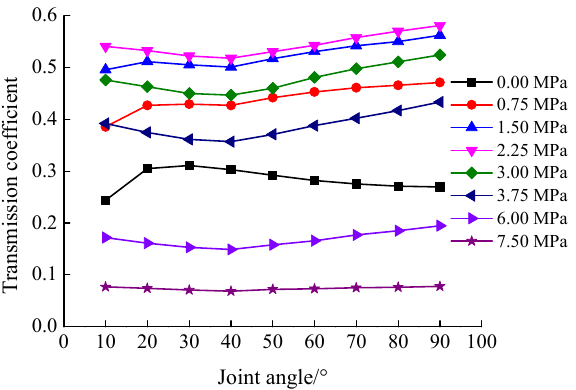
Figure 12. Effect of the joint angle on the transmission coefficient under different biaxial static loads.